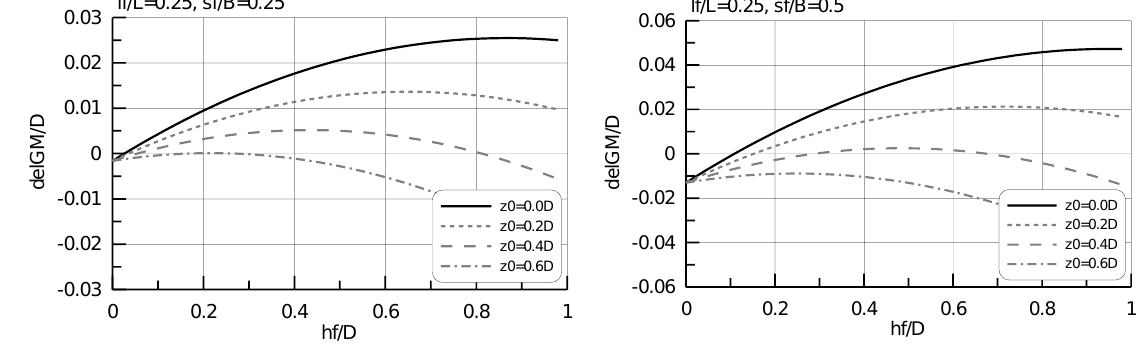
Figure 5. C hanges in GM, according to the depth of the flooded water. Figure 5. Changes in GM , according to the depth of the flooded